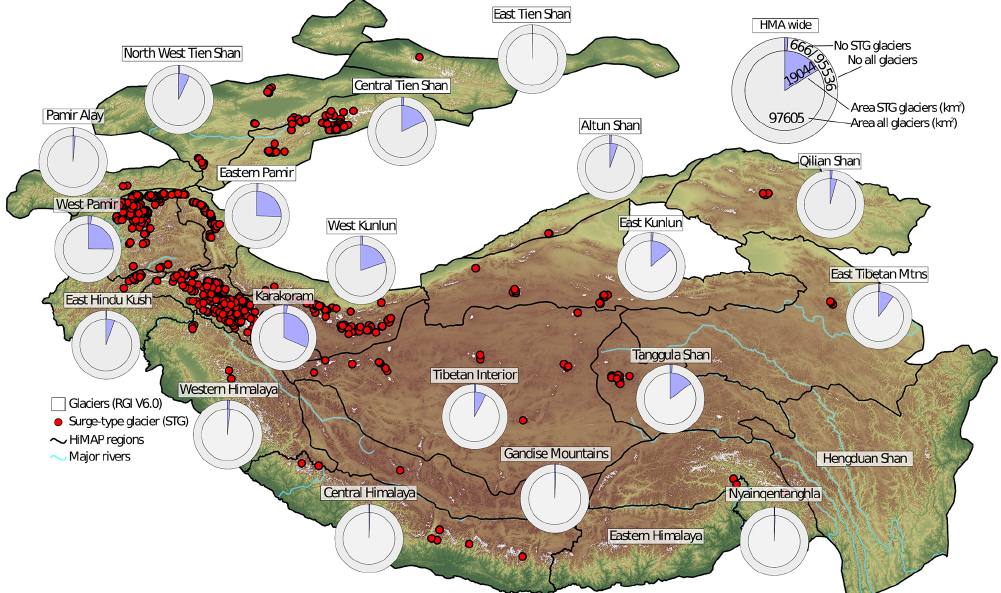
Figure 4. The distribution of surge-type glaciers (red dots) across HMA, identified by our multi-factor remote sensing approach. The number and area of surge-type glaciers within each HIMAP region (Bolch et al., 2019), compared to the total glacier population, are also shown. Prominent but well-known clusters of surge-type glaciers are evident in the Pamirs and Karakoram, but our analysis has also confirmed and detected smaller clusters of surge-type glaciers across the Tibetan Plateau and Tien